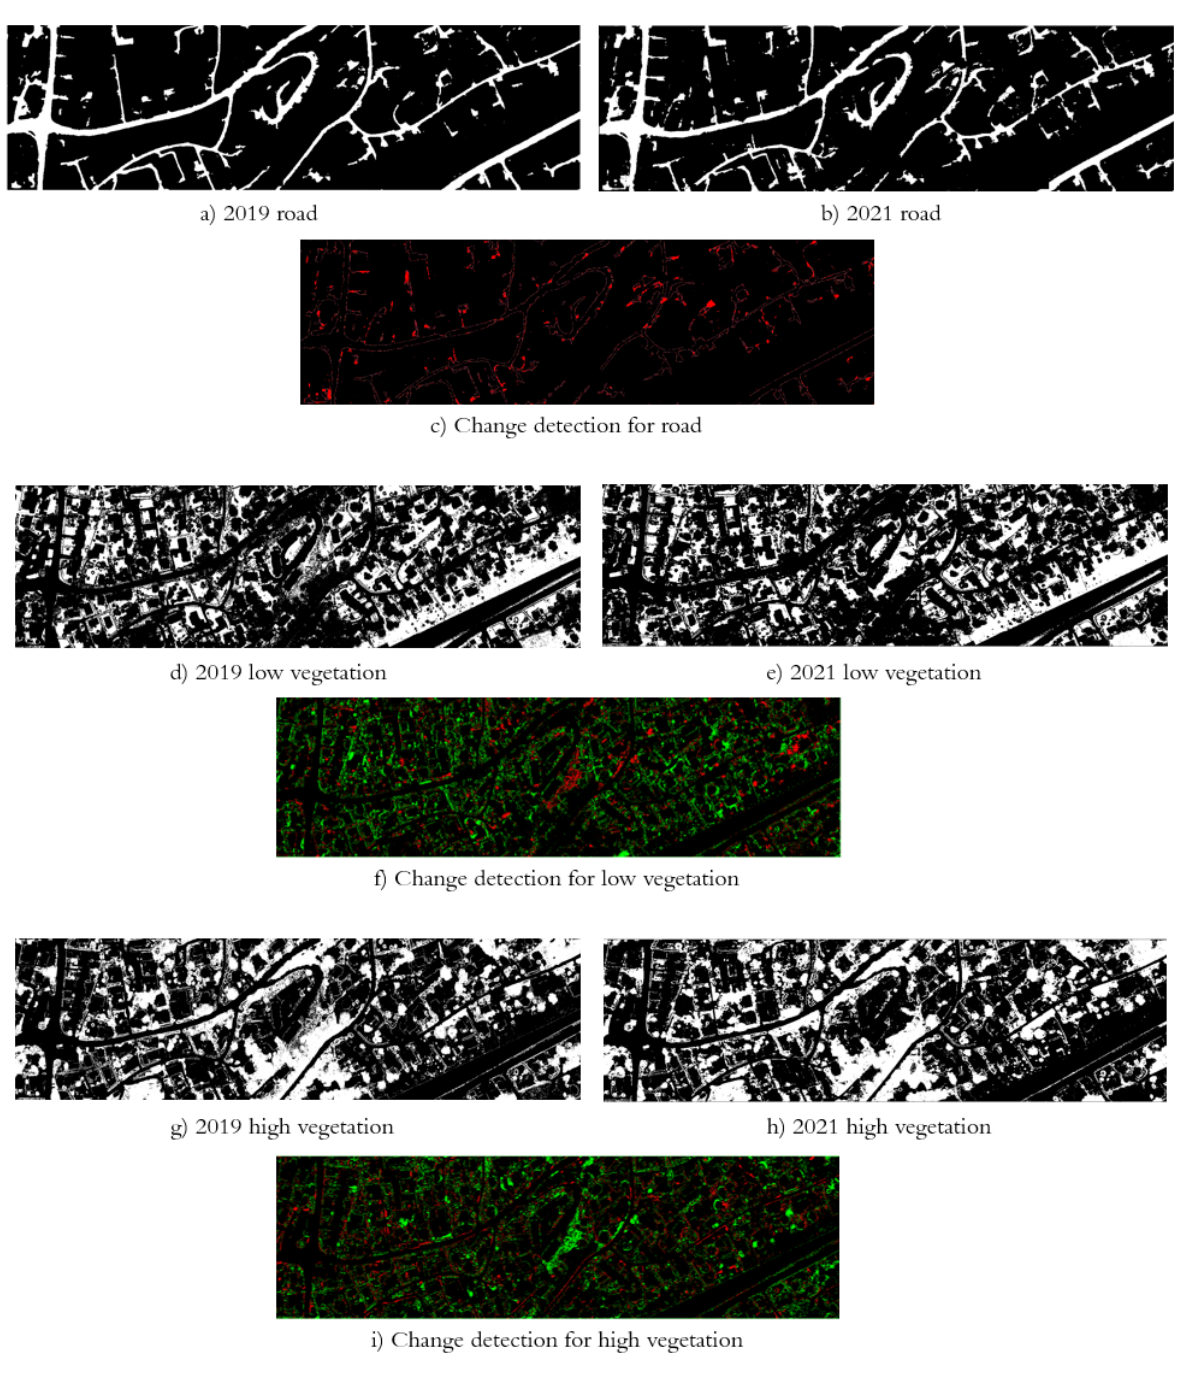
Figure 11. Change detection results for roads, low and high vegetation from 2019 to 2021 representing ( a ) buildings from 2019, and ( b ) from 2021, ( c ) change detection for buildings, ( d ) low vegetation from 2019, and ( e ) from 2021, ( f ) change detection for ow vegetation, ( g ) high vegetation from 2019, and ( h ) from 2021, and ( i ) change detection for high vegetation. Red color highlights changed pixels in the updated map. The green color represents pixels available only in the 2019 map (a map to be updated).